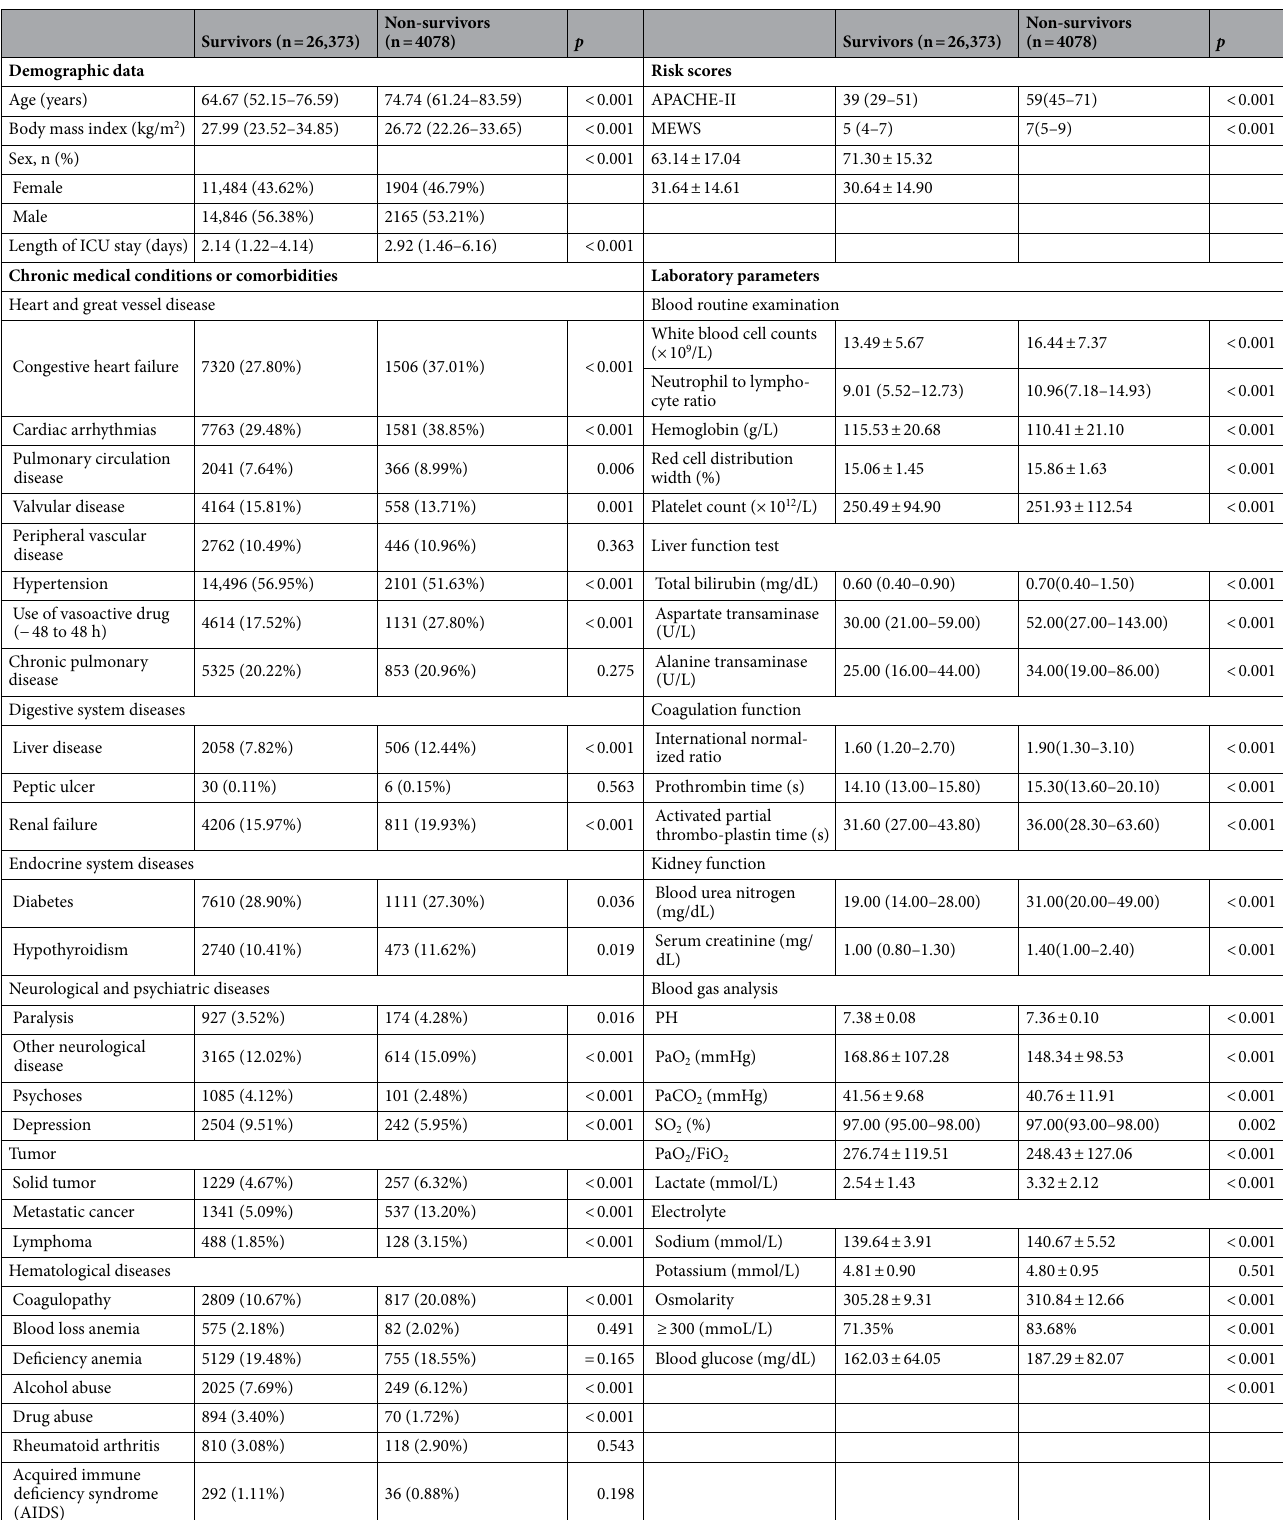
Table 4. Baseline characteristics and comparisons of demographics data, chronic medical conditions or comorbidities, risk scores and laboratory parameters of the study population between different survival status in development group. The normally-distributed continuous variables are shown as mean values and standard errors. The non-normally-distributed continuous variables are shown as medians. The categorical variables are shown as proportions of each subgroup. The comparison of baseline data between survivors and nonsurvivors is performed by t test for normally distributed data, the Mann–Whitney U test for non-normally distributed data, and the chi-squared test for categorical